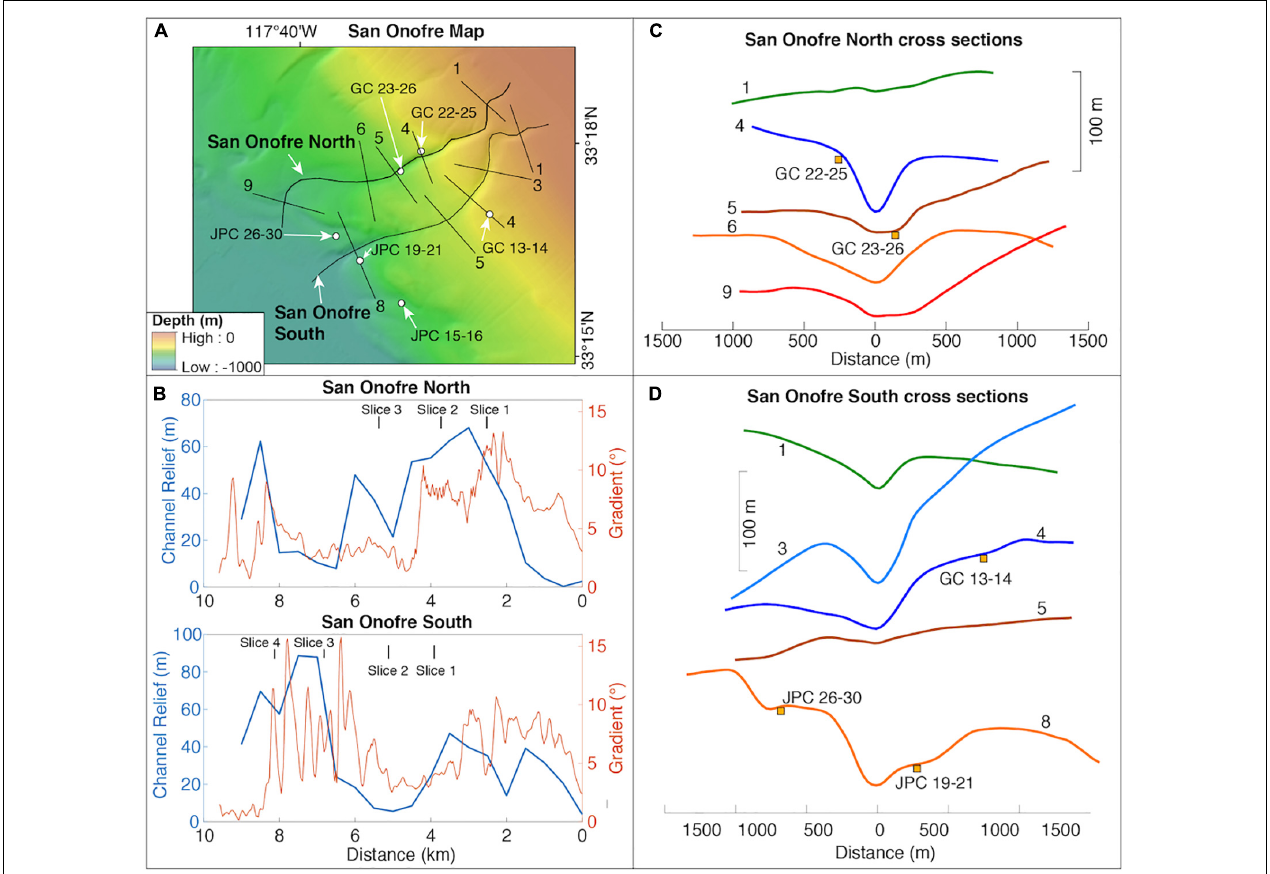
FIGURE 4 | (A) Bathymetry of the San Onofre North (SON) and South (SOS) Canyons. Cross-sections numbers correspond to their distance (in km) from the start of the bathymetric profile and are shown in panels C and D . Sediment cores are labeled. (B) Channel relief is plotted relative to channel slope for the two canyons. The intersections of the 3D Multichannel Sparker slices with the canyons are indicated at the top of the plots. (C,D) Cross sections through the SON and SOS canyon- channels are plotted. Horizontal and vertical scales are shown. Sediment cores were projected onto cross-sections and are indicated by yellow